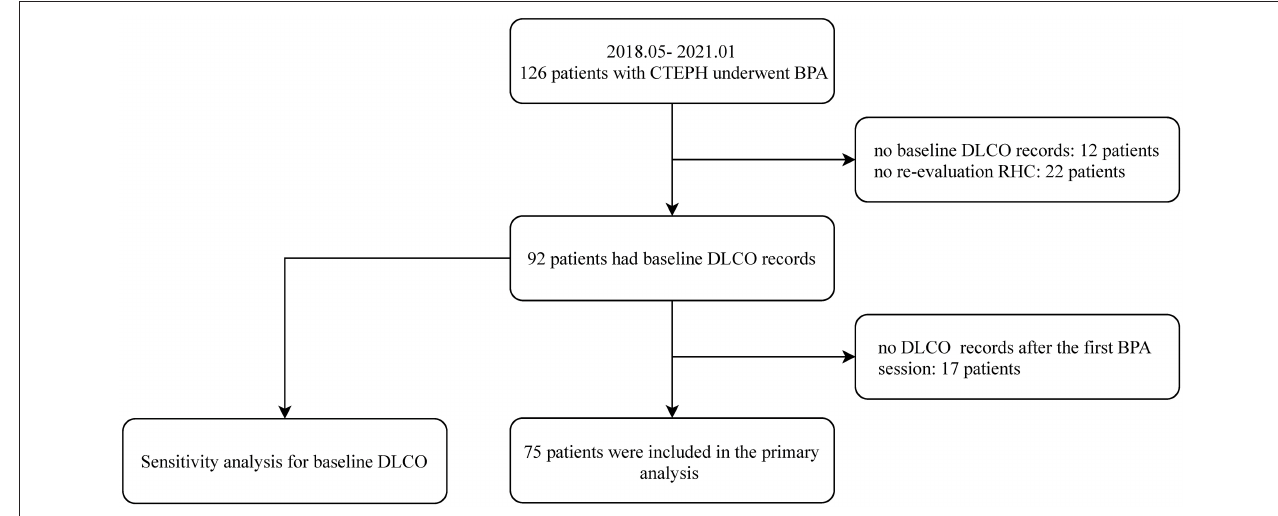
FIGURE 1 | The patient enrollment flow chart. BPA, balloon pulmonary angioplasty; CTEPH, chronic thromboembolic pulmonary hypertension; DLCO, diffusing capacity for carbon monoxide; RHC, right heart